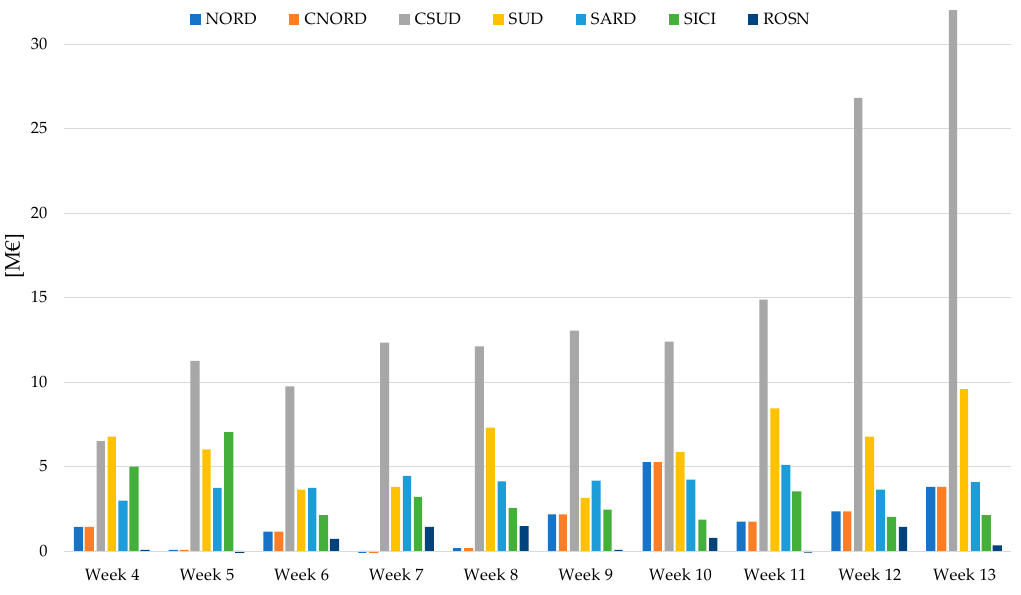
Figure 24. Weekly system costs for ancillary services, per each market zone. Energies 2020 , 13 , x FOR PEER REVIEW